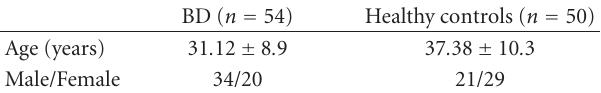
Table 2: Demographic data (mean ± SD).